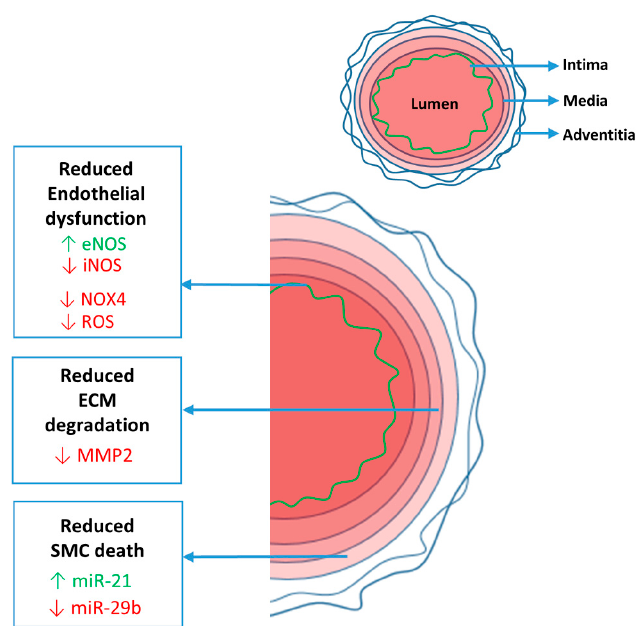
Figure 1. Resveratrol improves pathological aortic features in Marfan syndrome by enhancing beneficial (green) eNOS and miR-21 and decreasing detrimental (red) iNOS, NOX4, ROS, MMP2 and miR-29b. eNOS or iNOS: endothelial or inducible nitric oxide synthase; miR-21 and miR-29b: microRNA-21 and -29b; NOX4: NADPH oxidase 4; ROS: reactive oxygen species; MMP2: matrix metalloproteinase 2.